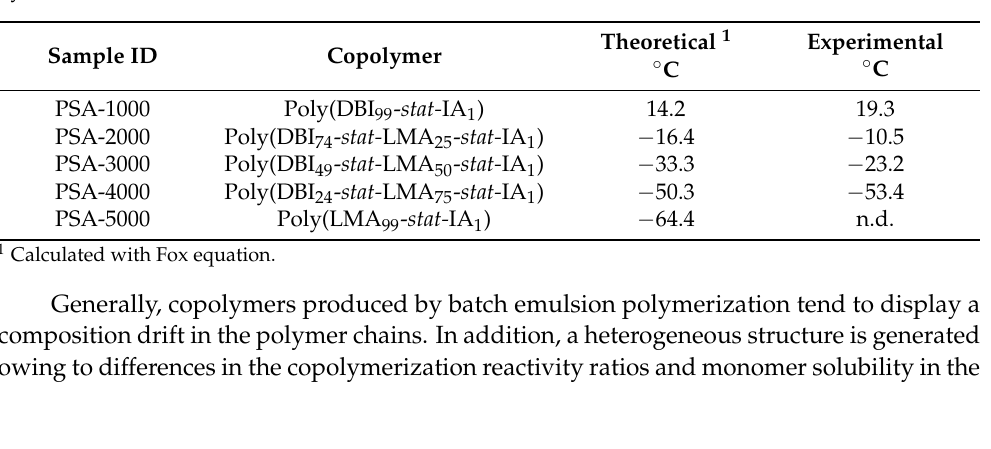
Table 3. Comparison of theoretical versus experimental glass transition temperature obtained by DSC